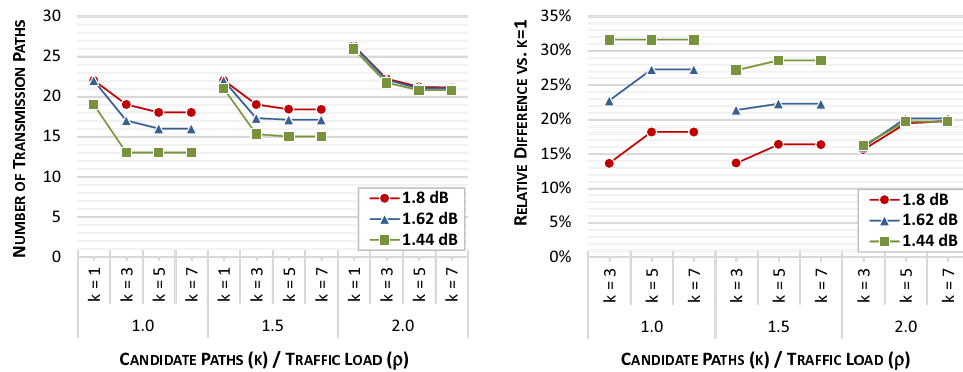
Figure 6. The number of transmission paths ( left ) and relative difference versus a single-path scenario ( right ) in a function of traffic load ( ρ ) and the number of candidate routing paths ( k ) for different MUX loss values in